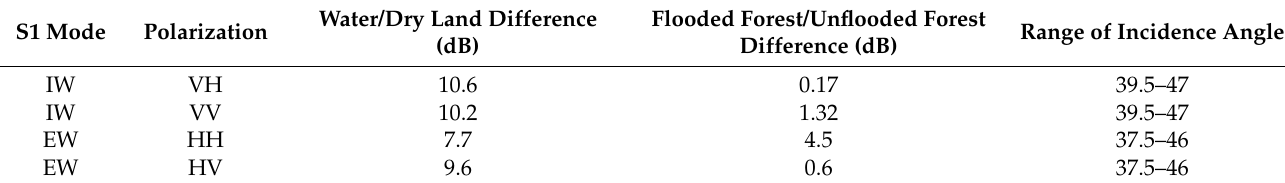
Table 4. Summary of sensitivity analysis for land and water discrimination for different S1 polarizations [52]. Water/Dry Land S1 Mode Polarization